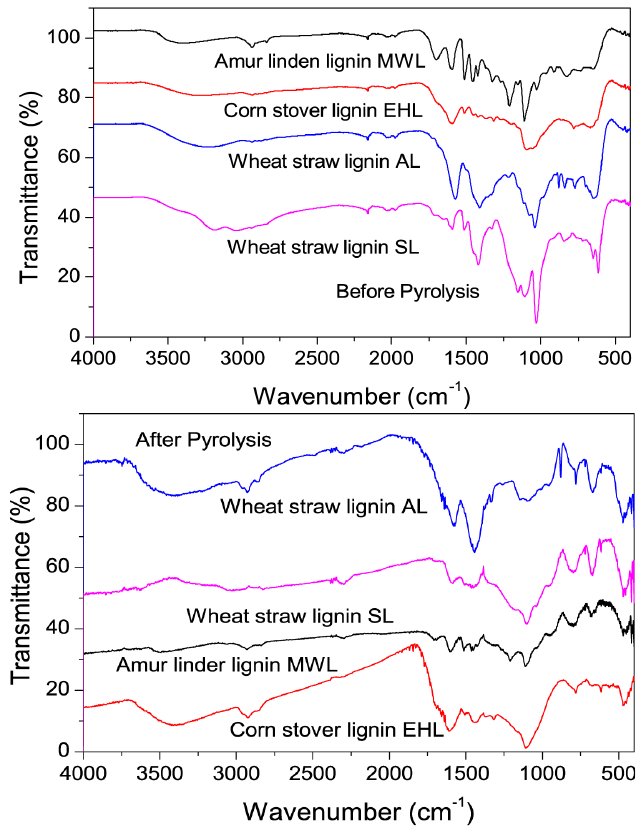
Figure 2. FTIR spectra of the four lignins before and after pyrolysis. MWL: Amur linden milled wood lignin; EHL: corn stover enzymatic hydrolysis lignin; AL: wheat straw alkali lignin; SL: wheat straw sulfonate